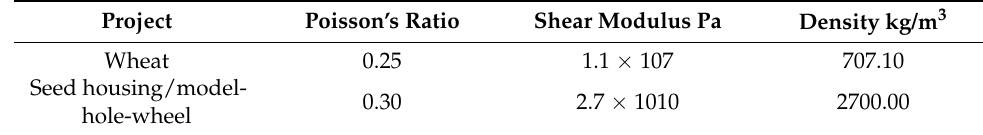
Figure 5. Simulation model. ( a ) Seed metering device model; ( b ) Wheat seed model. Table 2. Physical properties of wheat and seed